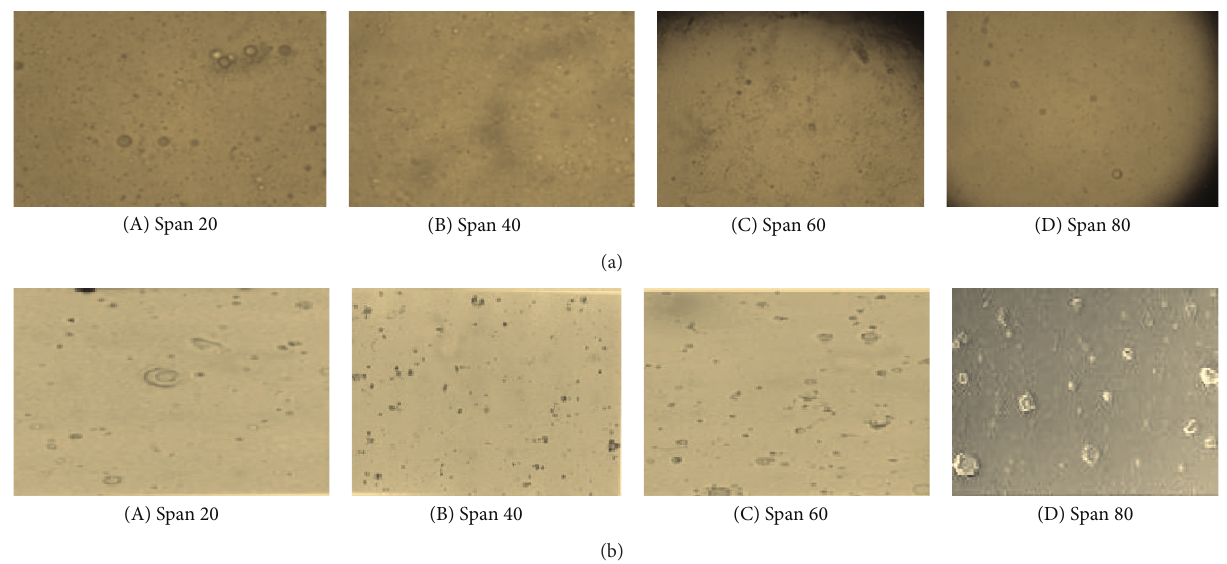
Figure 1: Optical microscopy of niosomes. (a) Empty and (b) drug loaded at 45x magnification.